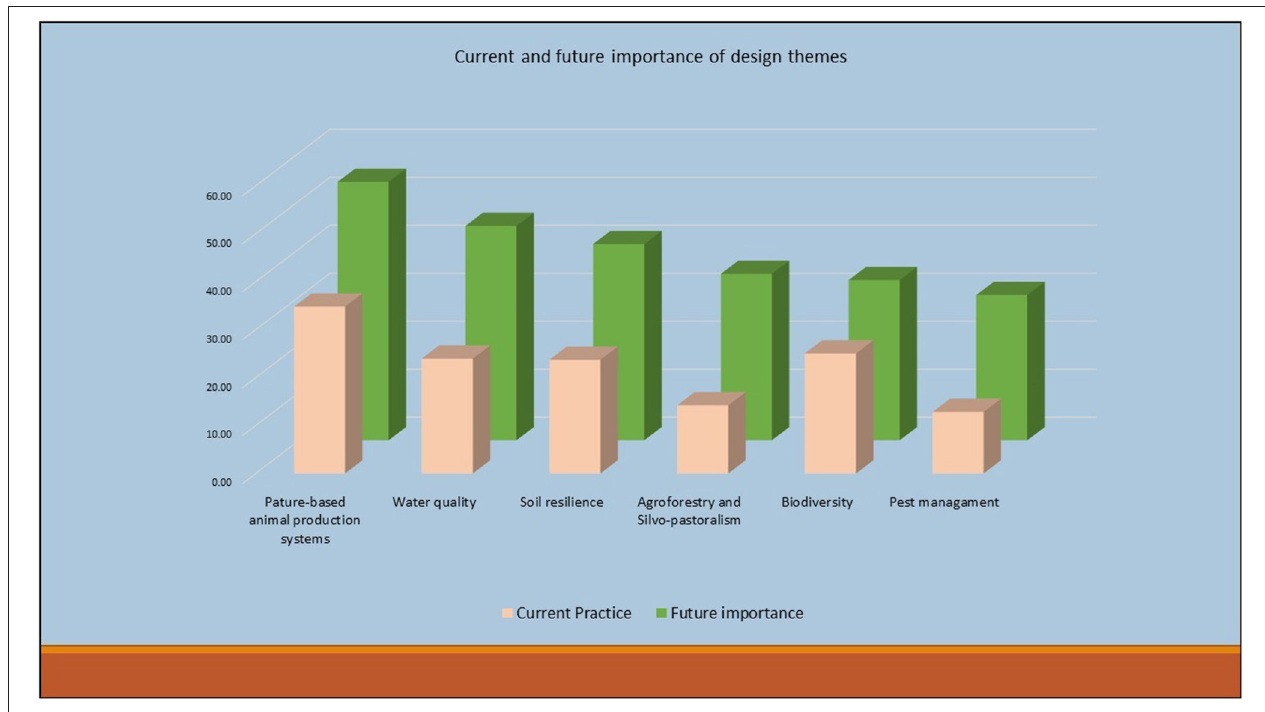
FIGURE 7 | Results of participatory opinions on COE design themes for landscape re-design ( n =